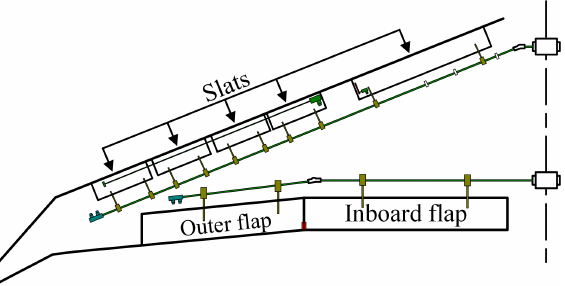
Figure 1. Aircraft’s movable surfaces are attached to the